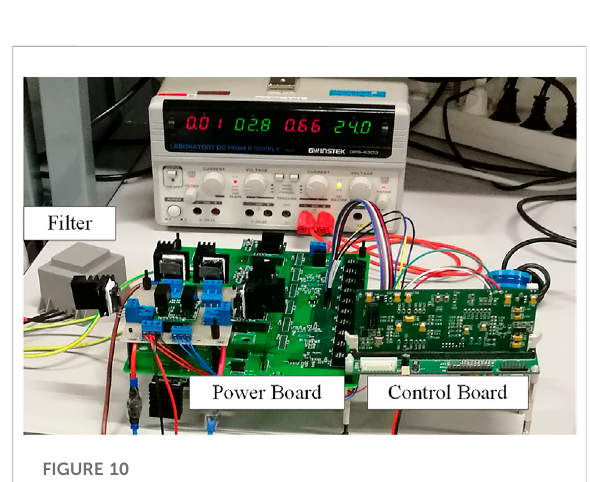
Experimental prototype of the proposed